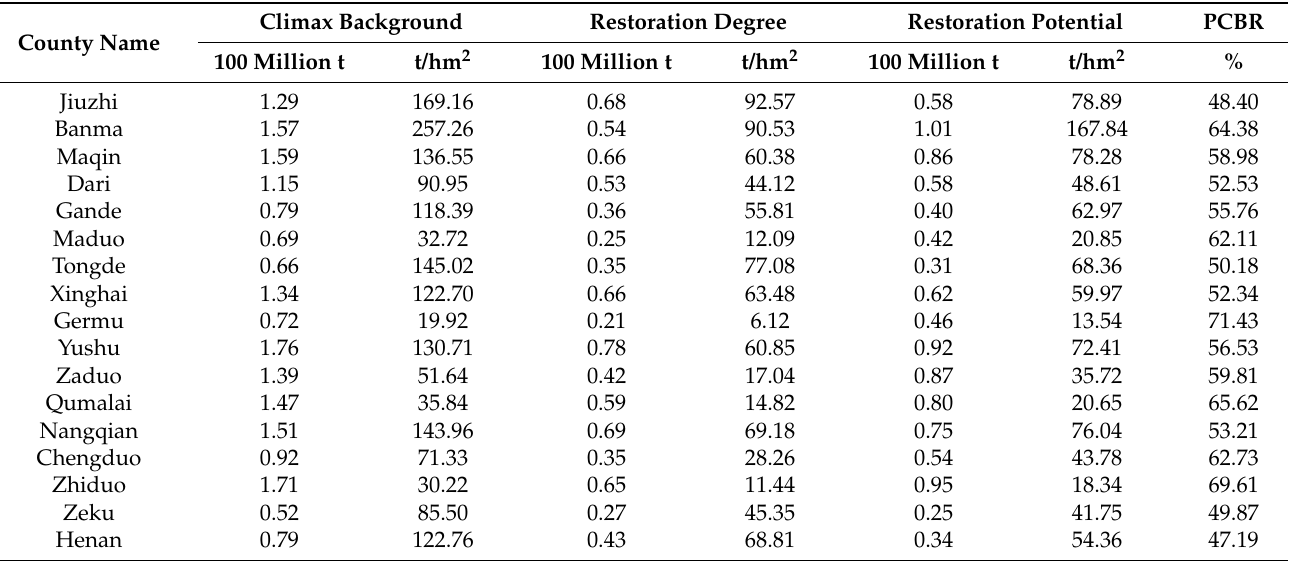
Table 4. Statistical table of climax background, restoration degree, restoration potential, and PCBR of SR in TRHR’s counties.